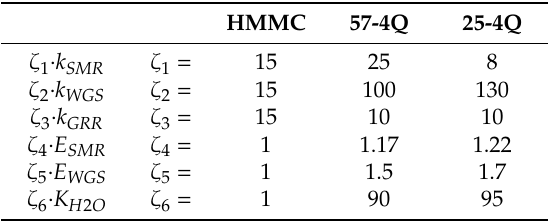
Table 5. Values of the adjusting dimensionless coe ffi cients ζ 1 to ζ 6 , adopted to adapt the Xu and Froment kinetic parameters [24] to the catalysts investigated in this work.